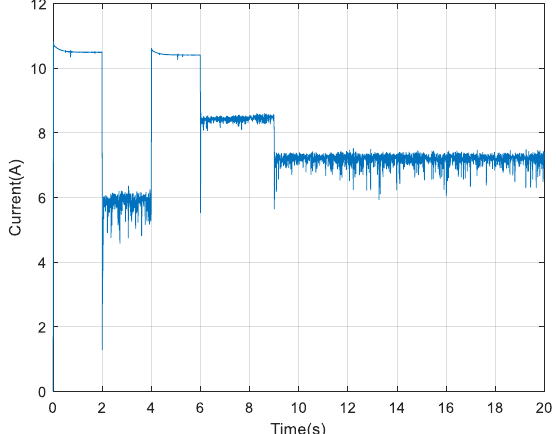
Figure 19. Temporal evolution of the motor current.